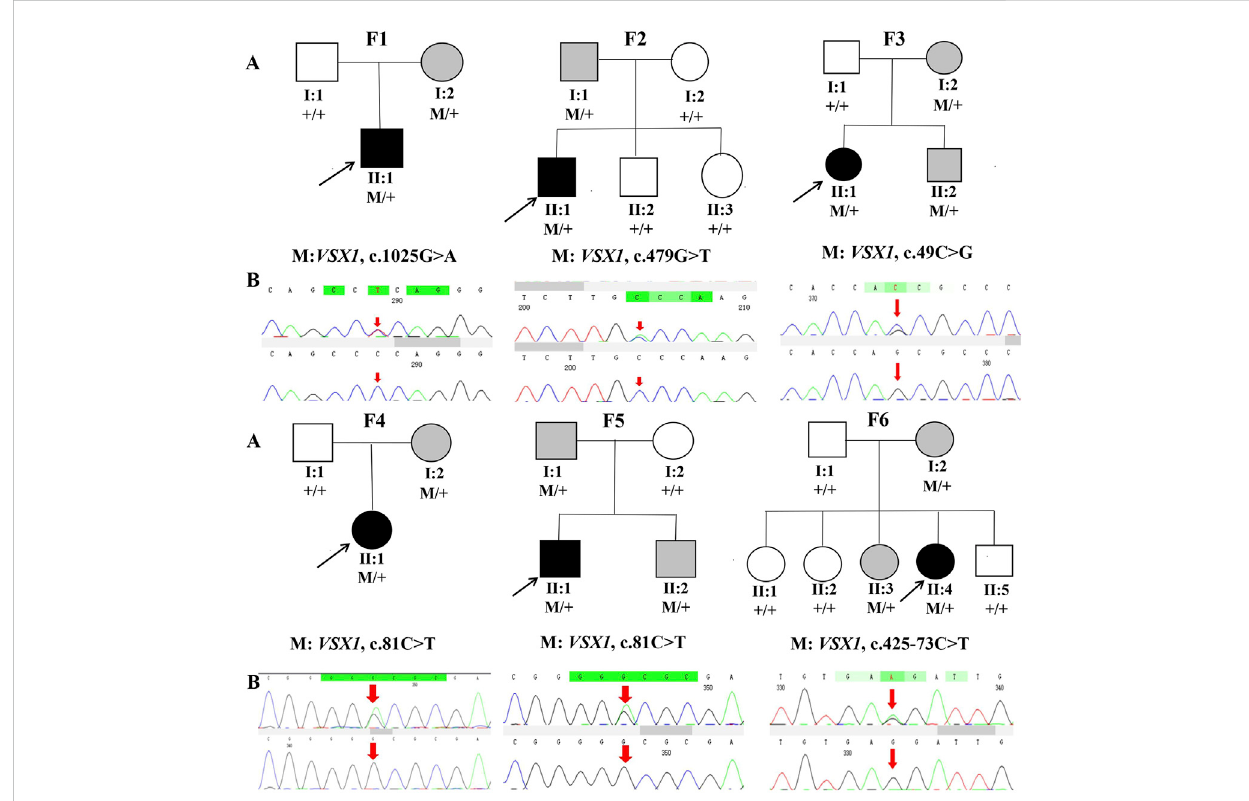
FIGURE 1 Pedigrees and DNA sequence chromatograms of affected (top) and unaffected (bottom) individuals among the sixKC families. (A) Pedigree charts. Black symbols indicate the proband, white symbols indicate unaffected individuals, gray symbol indicate asymptomatic variant carriers with suspicious clinical parameters in Pentacam and Corvis ST. M represents a variant, and + indicates a normal allele. (B) The Sequence chromatograms; R arrow represents a mutant